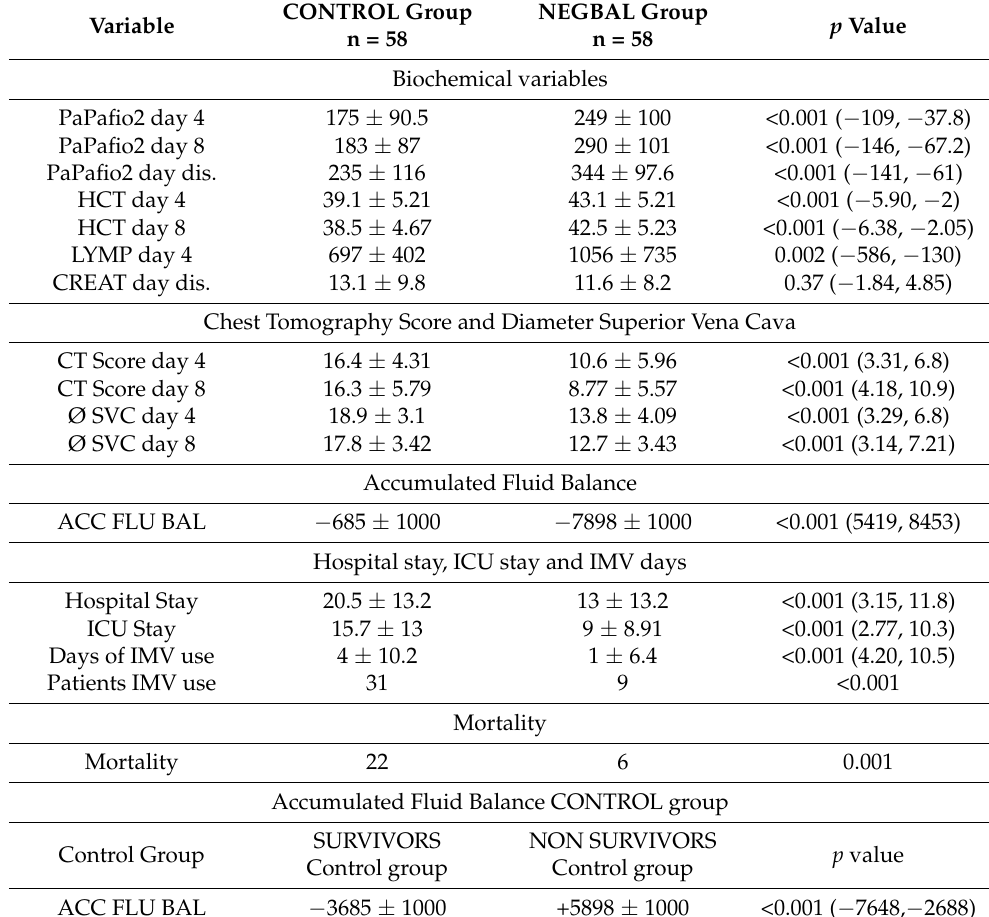
Table 2. Comparative analysis during evolution of